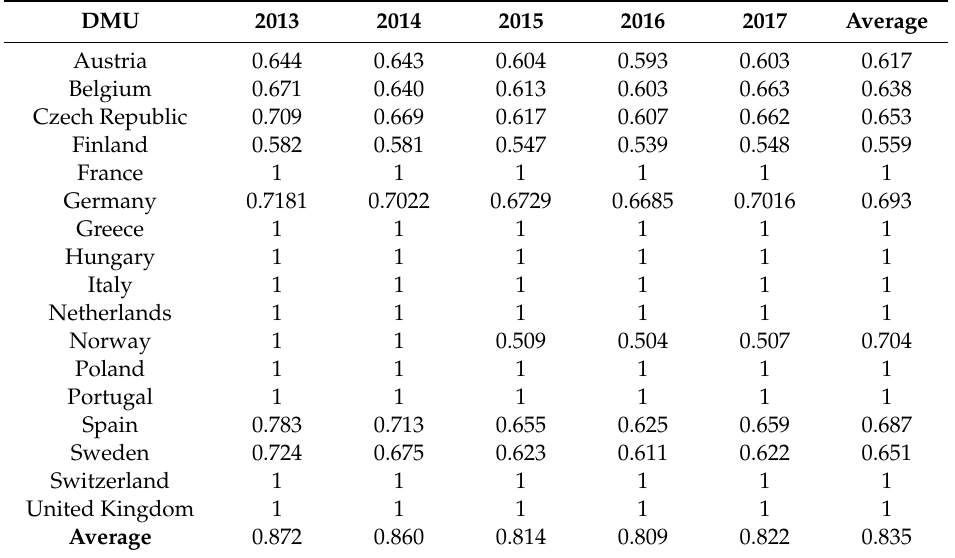
Table 6. Results of eco-e ffi ciency obtained from Slacks-based measure (SBM) DEA for the 17 DMUs (2013 to